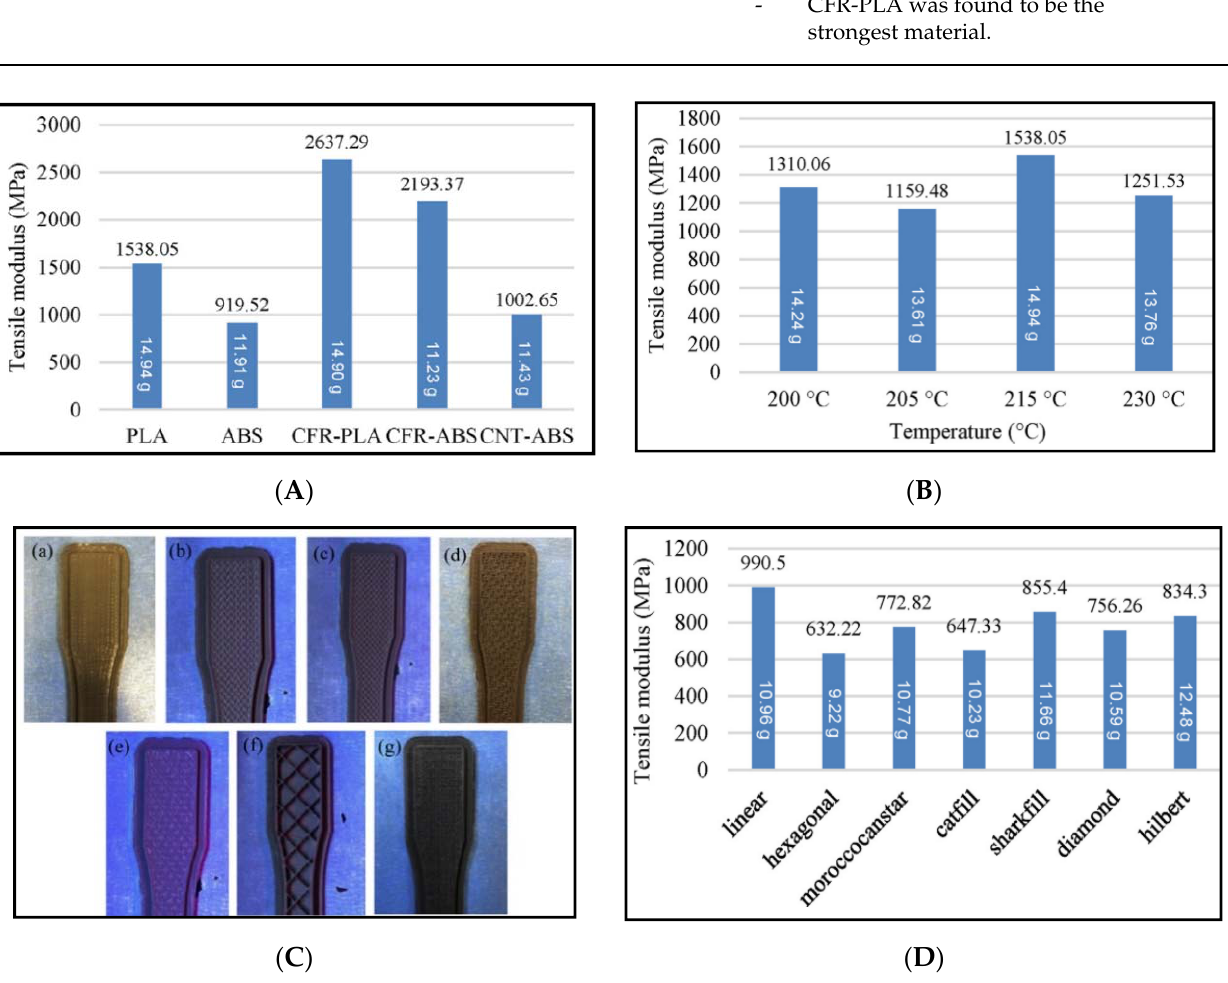
Figure 15. ( A ) Modulus of five different 3D printed materials. ( B ) Modulus of PLA at different nozzle temperatures. ( C ) PLA sample with infill patterns: ( a ) linear, ( b ) hexagonal, ( c ) moroccanstar, ( d ) catfill, ( e ) sharkfill, ( f ) diamond, and ( g ) Hilbert. ( D ) Modulus of PLA@50% infill density under different infill patterns (available under Creative Commons license